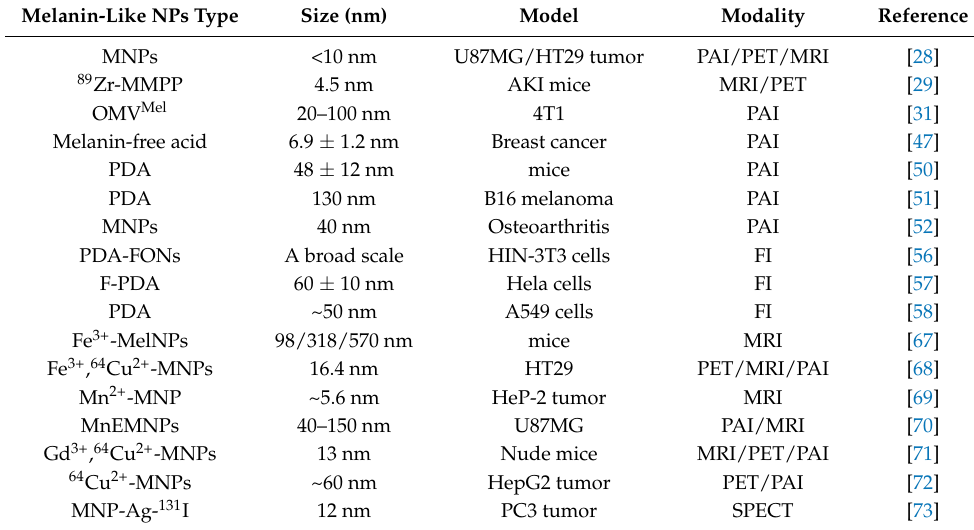
Table 1. Examples of melanin-like NPs for bioimaging applications. Melanin-Like NPs